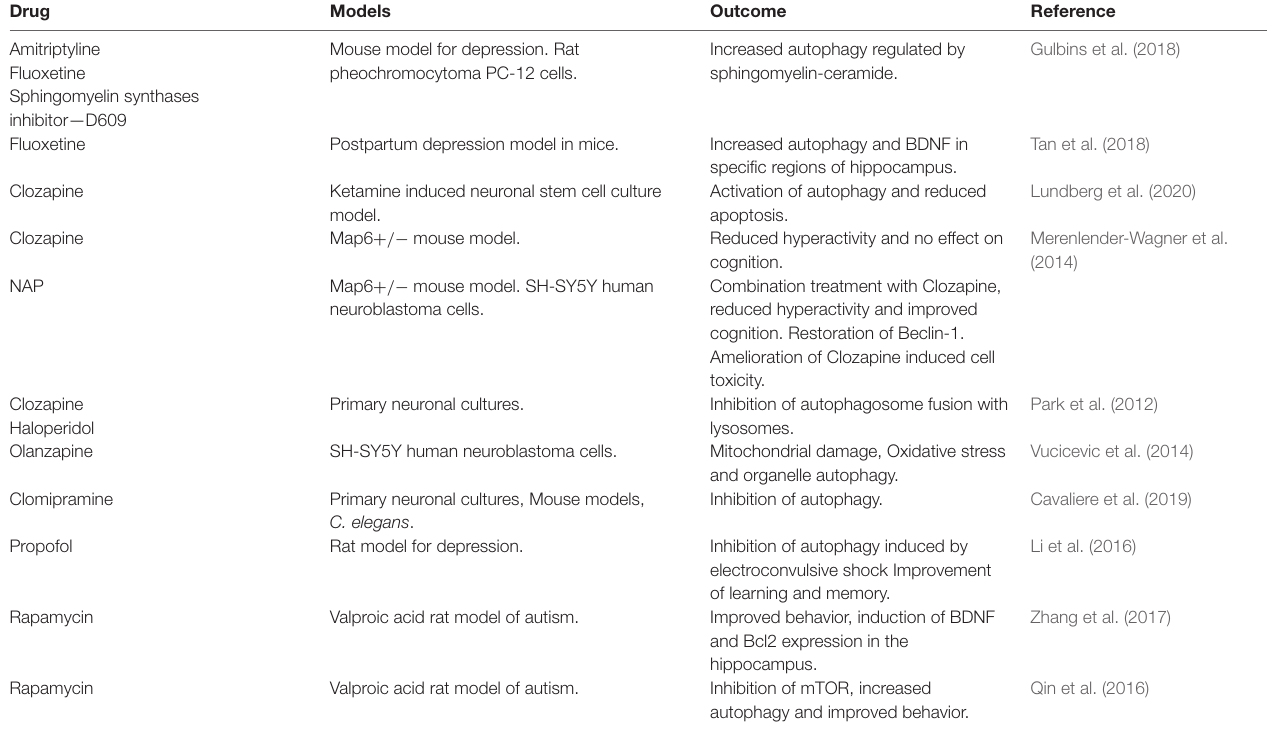
TABLE 2 | Drugs targeting